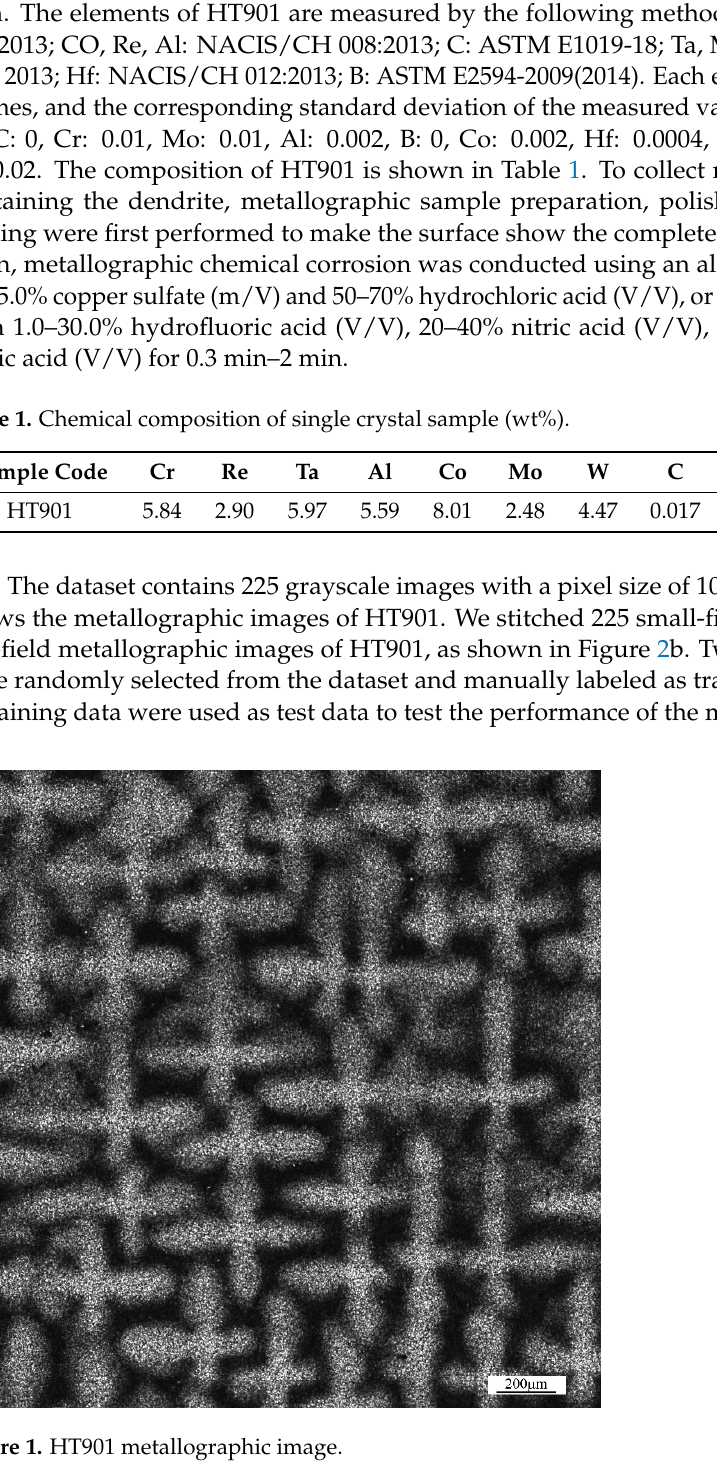
Table 1. Chemical composition of single crystal sample (wt%).